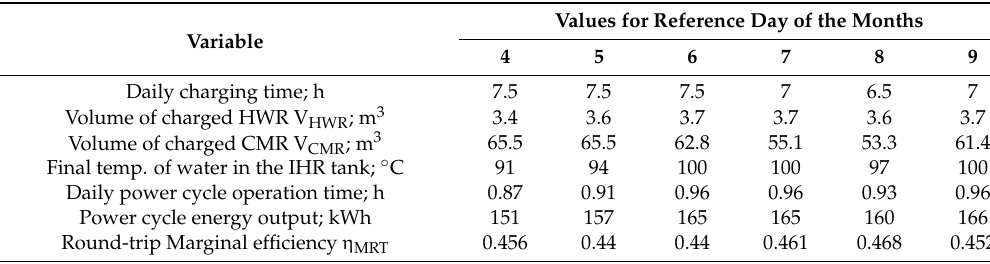
Table 6. Off-design simulations results for system operating in Crotone.